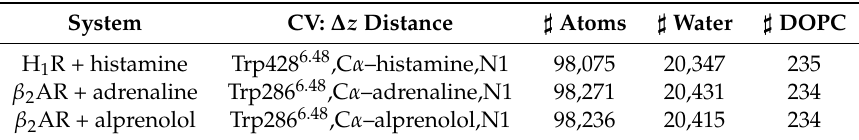
Table 4. Overview of the systems investigated. The table lists the atoms between which the binding collective variable (CV) was defined as well as the total number ( (cid:93) ) of atoms, water molecules, and DOPC molecules in the system.